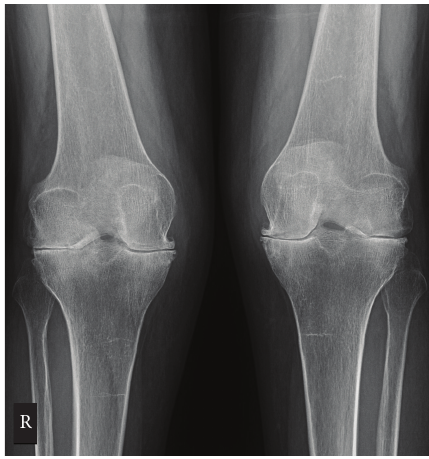
Figure 1: Posteroanterior radiographic view of bilateral knees demonstratingadvancedarthritis.Notethevalgusalignmenttoboth legs. RA and OA radiographs differ in that RA radiographs will show periarticular erosions and osteopenia, whereas periarticular osteophytes, subchondral sclerosis, and joint space narrowing are more common in OA.